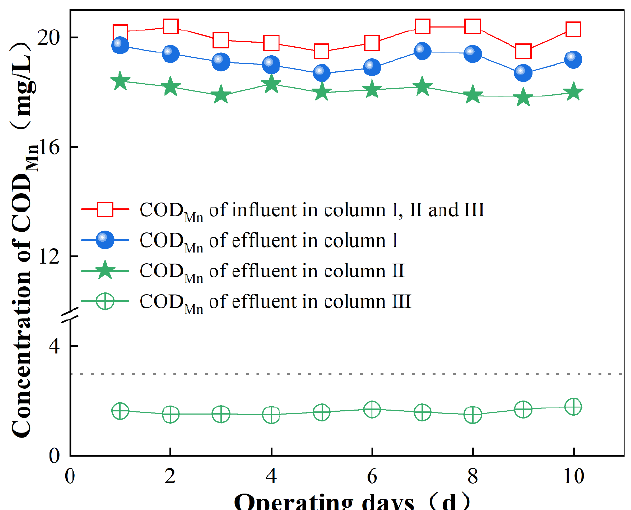
Figure 2. K 2 FeO 4 enhanced the MeO x for the removal process of COD Mn.